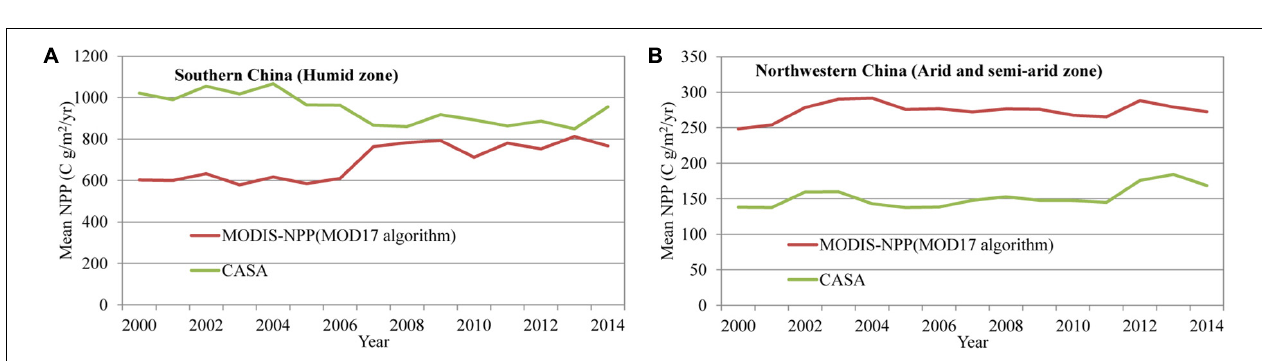
FIGURE 2 | A comparison of two NPP estimations across different vegetation zones. (A) Higher vegetation coverage zones. (B) Lower vegetation coverage zones.